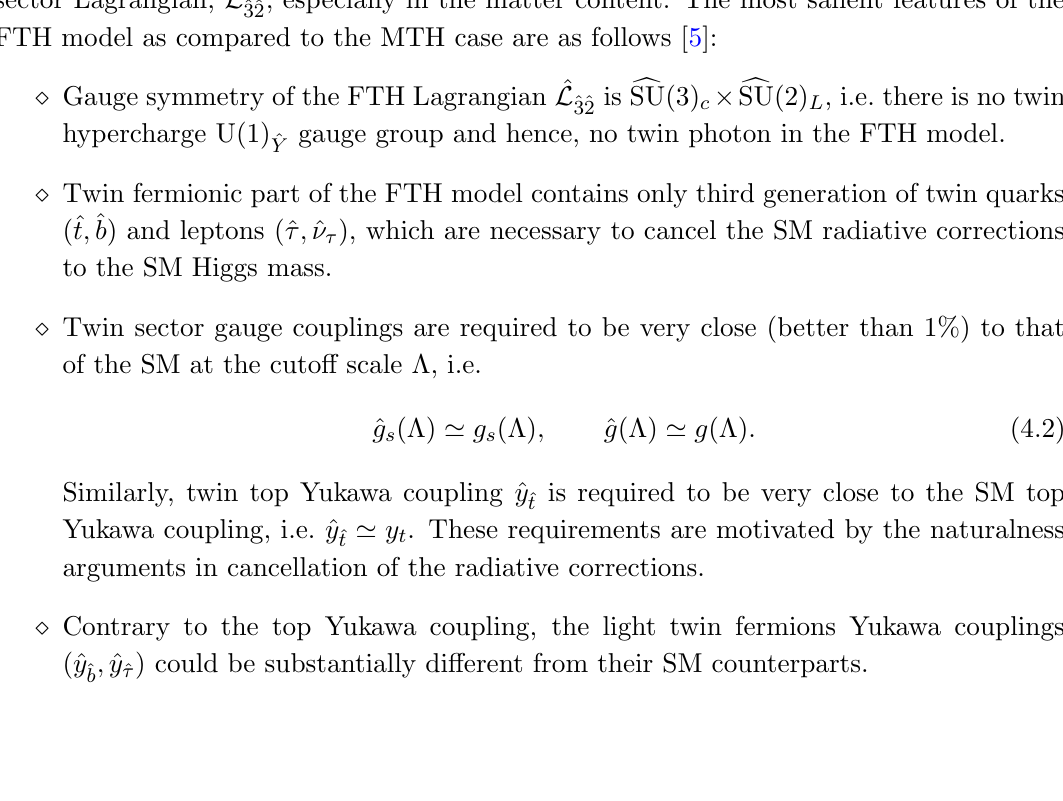
(cid:0) f=v plane for the MTH model with ~ (cid:26) = 0 (left) h =m ^ (solid h h hhh > m ^ h h